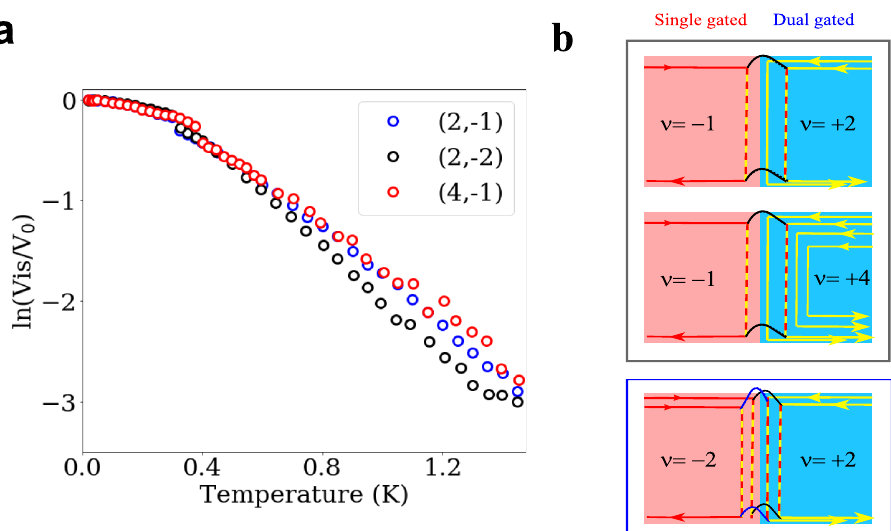
Fig.3|Thermaldecoherenceatvarious fi llingfactors.a InterferencevisibilityVisversustemperature,asinFig.2a,forthelargeinterferometerat( ν n , ν p )=(2, − 1),(2, − 2), (4, − 1). b Schematic representation of the different con fi